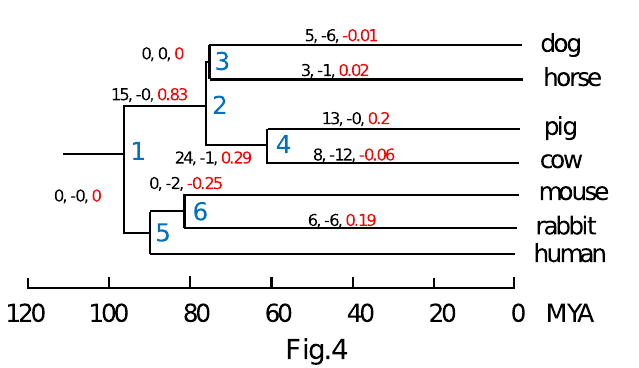
Figure 4. Gain and loss of clusters of duplicated miRNAs across the phylogenetic tree. The tree labelling is equivalent to Fig. 2.